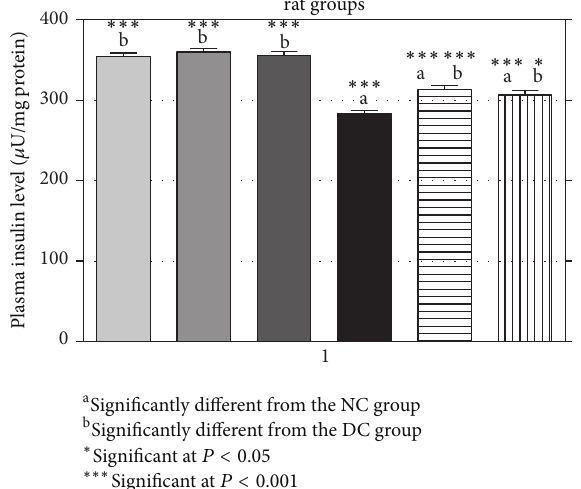
Figure 3: Balanites aegyptiaca fruits and Petroselinum sativum leaf aqueous extracts significantly ( 𝑃 < 0.001 ) increased the mean plasma insulin of the treated diabetic group in comparison with the DC group.